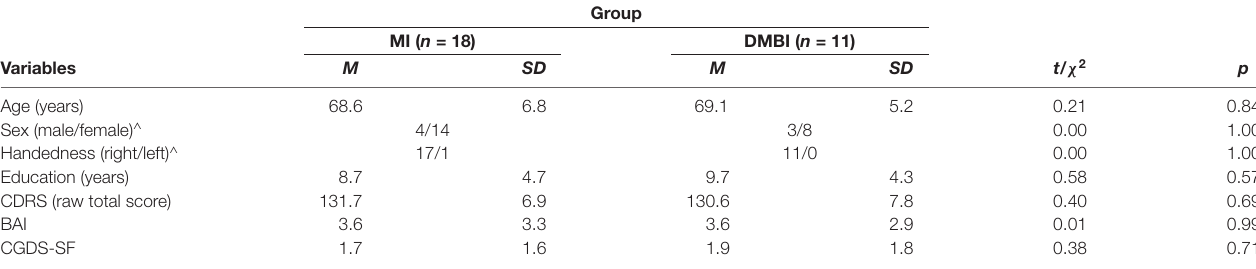
TABLE 1 | Demographic characteristics of the Memory Intervention (MI) and Dejian Mind-Body Intervention (DMBI) groups at